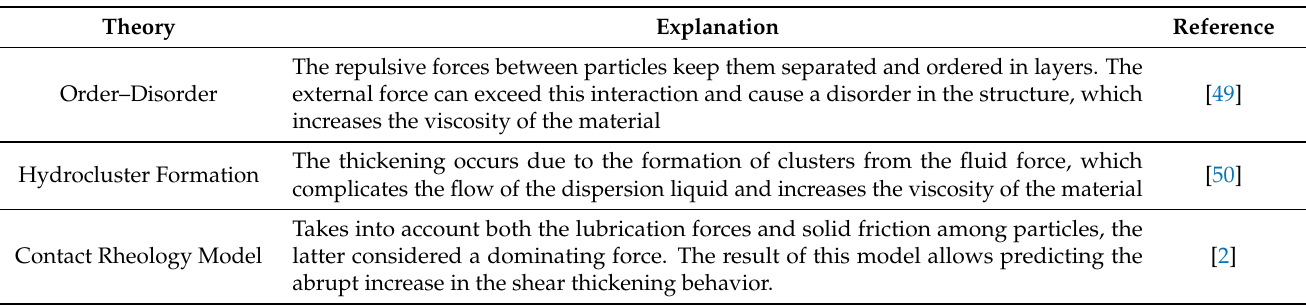
Table 2. Summary of theories to explain shear thickening fluids.